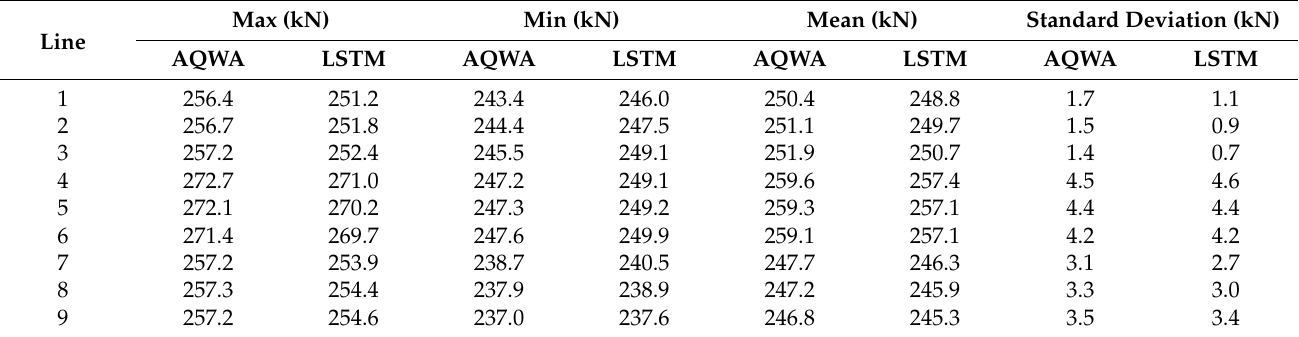
Table 13. Result statistics of AD10.